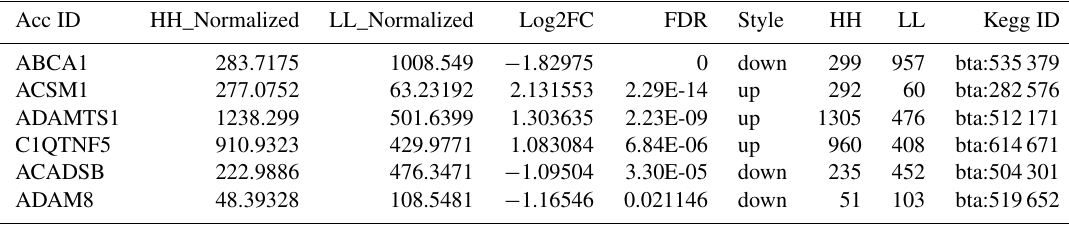
Table 1. Partial data about the differentially expressed genes of transcriptome